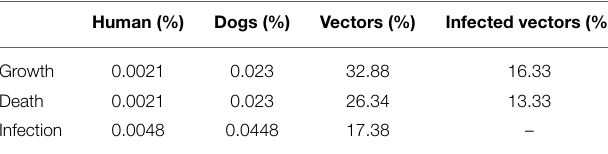
TABLE 3 | Comparison of the cumulative transition firing rates (in percentage) of the model in Figure 4. Human (%) Dogs (%) Vectors (%) Infected vectors (%)